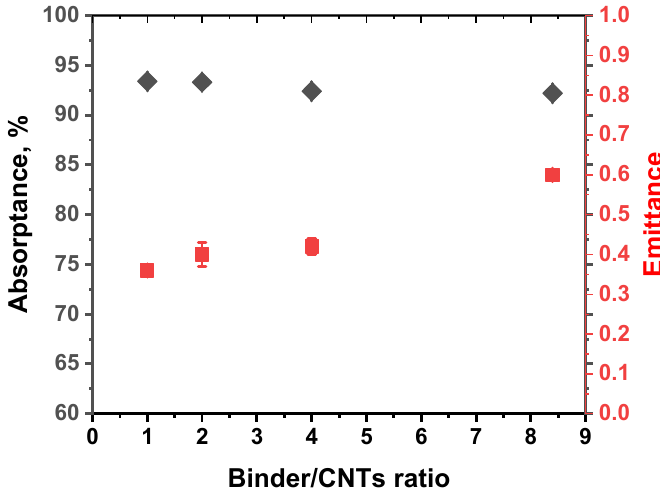
Figure 5. Absorptance and emittance as a function of binder/CNT ratio (calculated from the content in each layer) for a two-layer coating. CNT concentration in the formulation was 0.064%. ( ◆ — Absorptance, ■ —Emittance).